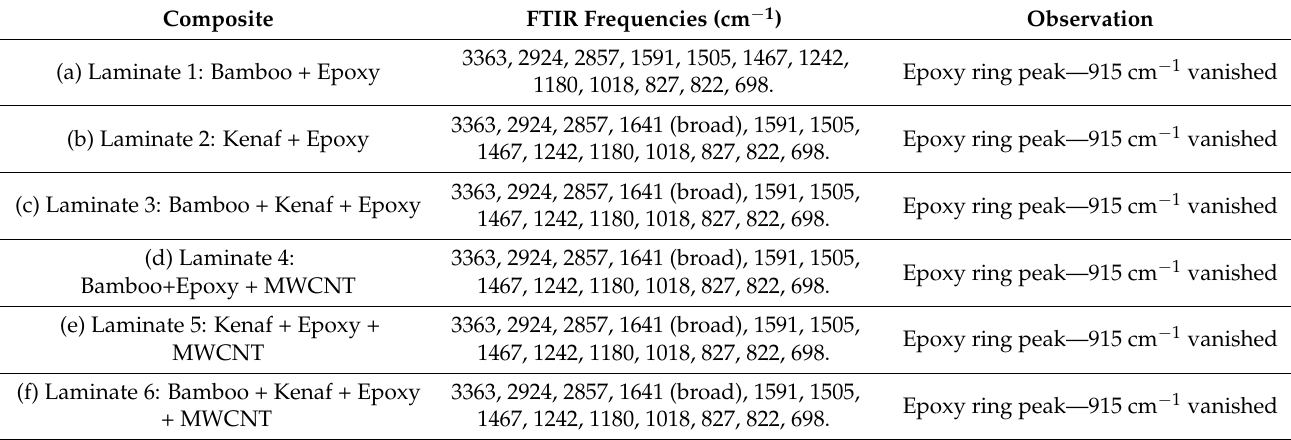
Figure 2. FT-IR spectra of Epoxy laminates consisting of natural fibres and/or MWCNT fillers. Table 3. FTIR vibrational spectra of prepared